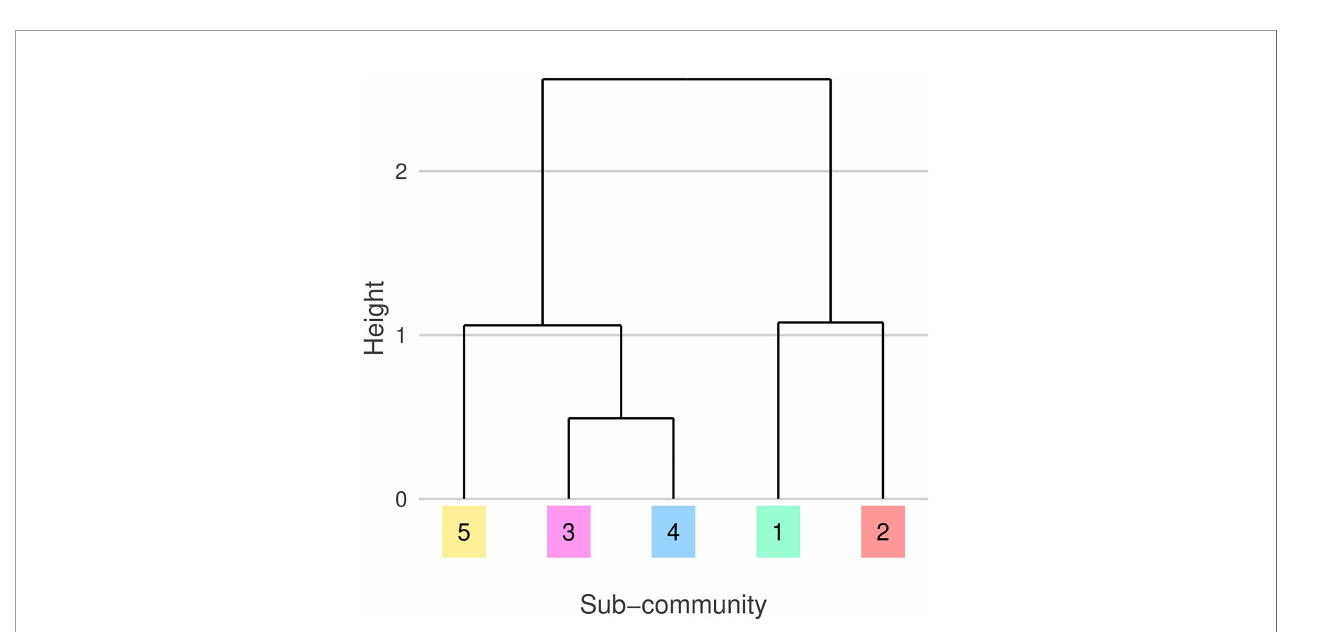
FIGURE 6 | Dendrogram showing hierarchical clustering of mean niche distances between sub-communities, emphasizing similarity illustrated in Figure 5 . Leaf colors and numeric-labels follow the shaded sub-community regions and labels from Figure 2